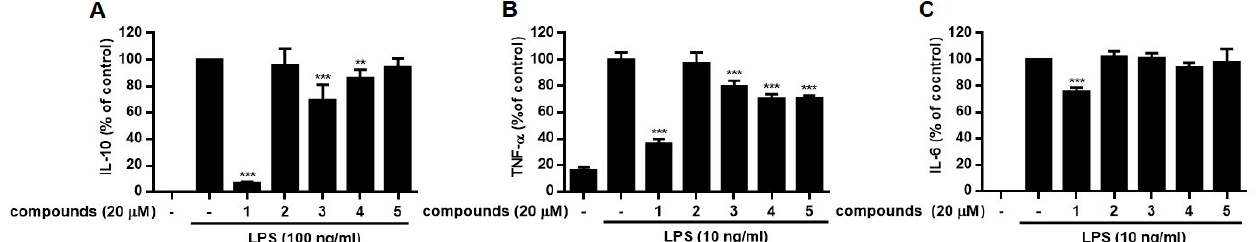
Figure 4. Effects of compounds 1 − 5 isolated from S. brachyotus on IL-10 ( A ), TNF- α ( B ), and IL-6 ( C ) production in LPS-stimulated RAW264.7 cells. The cells were treated with each compound (20 µM) for 1 h before exposure to 10 ng/mL (TNF- α , IL-6) or 100 ng/mL (IL-10) of LPS. After incubation for 3 h (TNF- α ), 6 h (IL-6), and 18 h (IL-10), the levels of IL-10, TNF- α , and IL-6 in the culture medium were subsequently measured using commercially available ELISA kits. Results are presented as the mean ± standard deviation from three independent experiments. The results differ significantly from LPS-only treated; ** p < 0.01, *** p < 0.001.